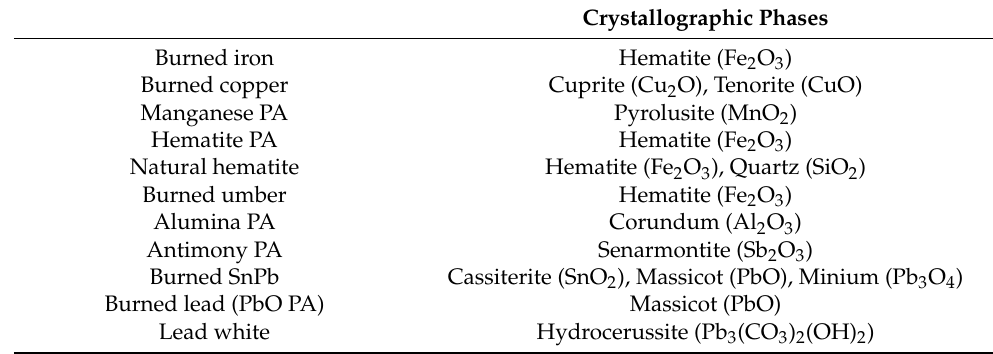
Table 4. Crystallographic phases of the coloring agents and other materials obtained by